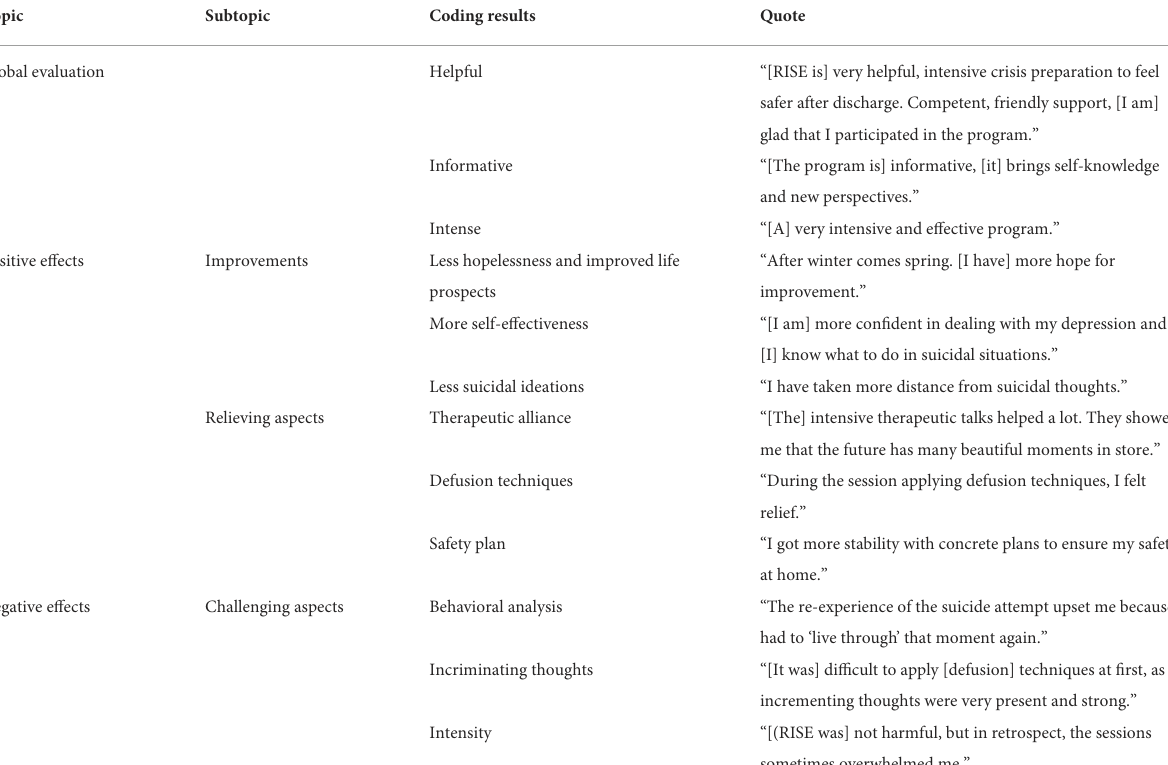
TABLE 3 Categorization of patients’s feedback regarding RISE feasibility.